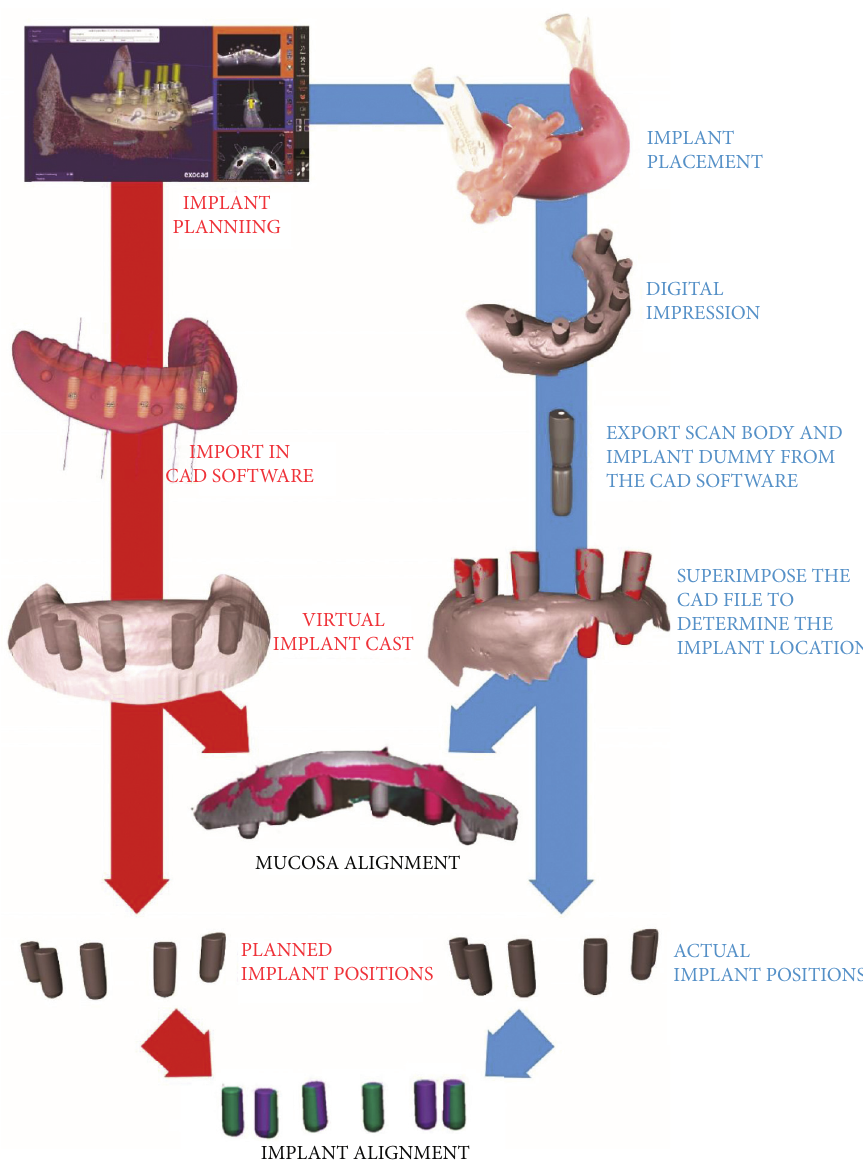
Figure 4: Actual and planned treatment plan superimposition regarding accuracy